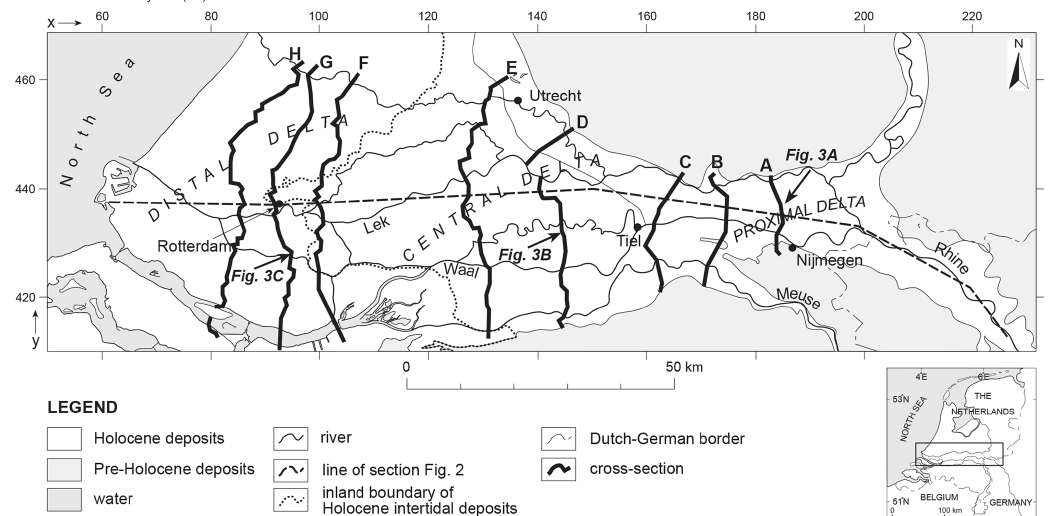
Figure 1. Location of the Rhine–Meuse delta, the Netherlands. The cross sections used in this study are designated A–H: cross-sections A–E are from Gouw and Erkens (2007), and sections F–H are from Hijma et al. (2009, modified). Definition of the proximal ( x = 160–220km), central ( x = 110–160km) and distal delta ( x = 70–110km) is based on Stouthamer et al. (2011). The current delta apex is located ∼ 20km upstream of the Dutch–German border.